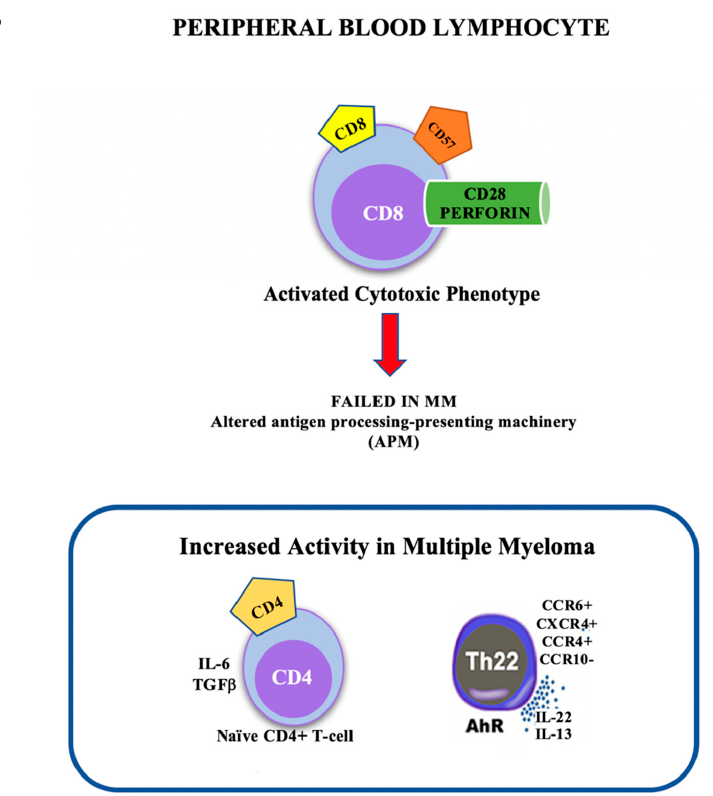
Figure 2. Cytokines and cell subsets involved in the multiple myeloma (MM) peripheral microenvironment. ( a ). Cytokines and cell subsets involved in MM bone marrow microenvironment. ( b ). Cytokines and cell subsets involved in MM peripheral